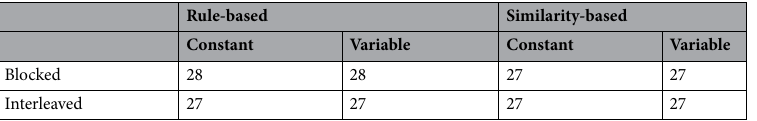
Table 2. Number of participants assigned to each of the eight conditions of the experiment. The table also includes the order manipulation for the two participants (assigned to conditions R+B+C and R+B+V) who were excluded from the study for not following